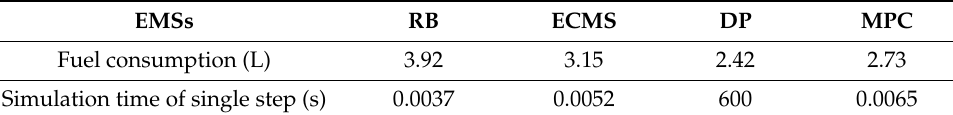
Table 2. The fuel consumption of four EMSs.